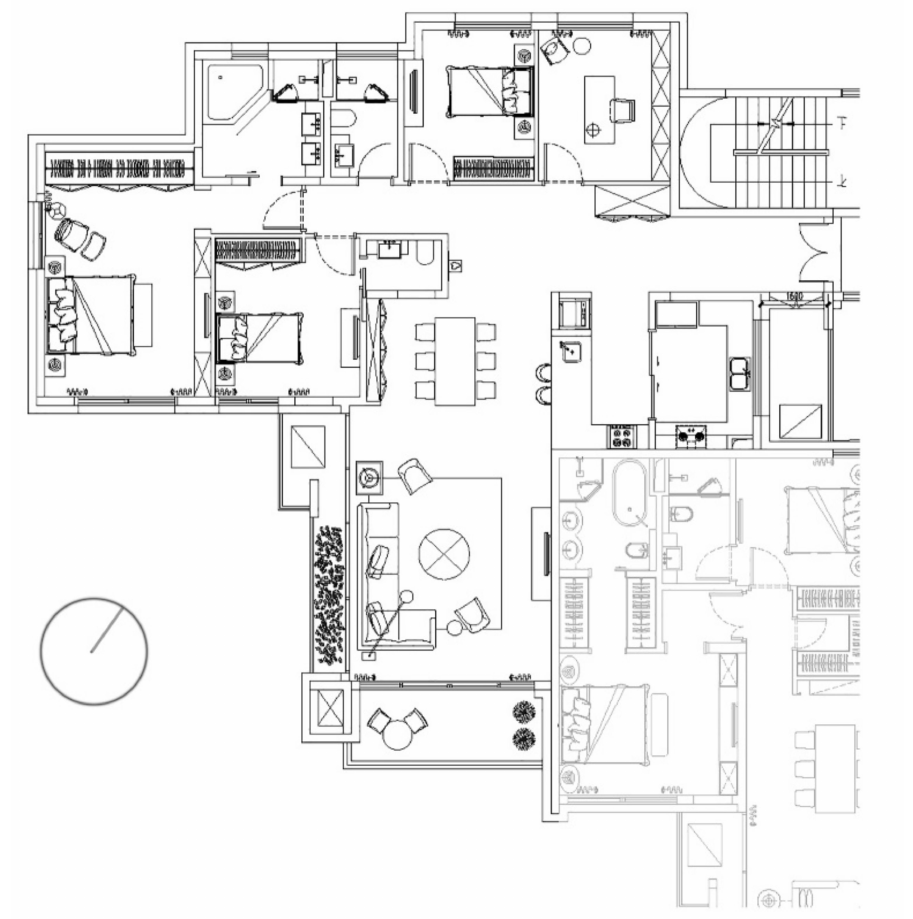
Figure 5. The layout of the studied